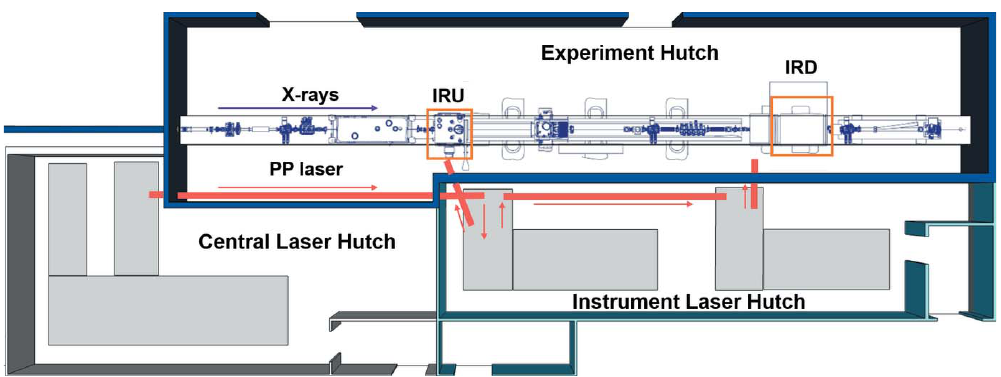
Figure 1 Top view of the general layout of the SPB/SFX instrument showing the central laser hutch, instrument laser hutch and experiment hutch. The two interactions regions are highlighted by orange boxes, the PP laser beam pipes and beam directions are marked in red, and the X-ray beam, marked in violet, goes from left to right.